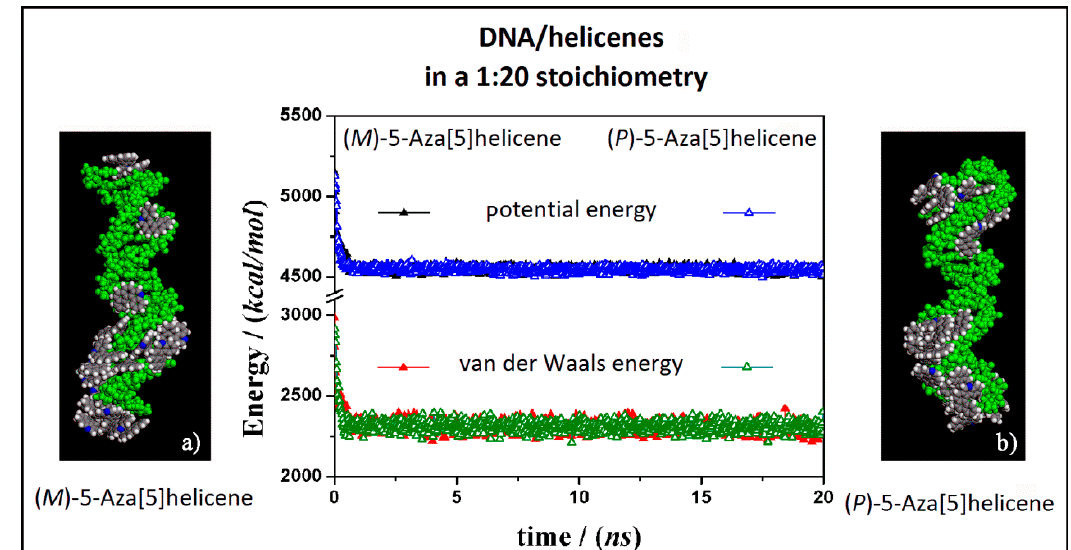
Figure 5. Optimized geometries of ( M )-5-Aza[5]helicene on the left ( a ) and ( P )-5-Aza[5]helicene on the right ( b ) after energy minimization of the conformation assumed by the system at the end of MD run considering enantiopure compounds in a 1:20 stoichiometry. In the central panel the potential energy and the van der Waals contribution calculated during the MD run for the ( M )-HA (full symbols, black and red respectively) and the ( P )-HA (empty symbols, blue and green respectively) are reported. All the DNA atoms are in green and the helicenes have the same color code as shown in Figure 3.